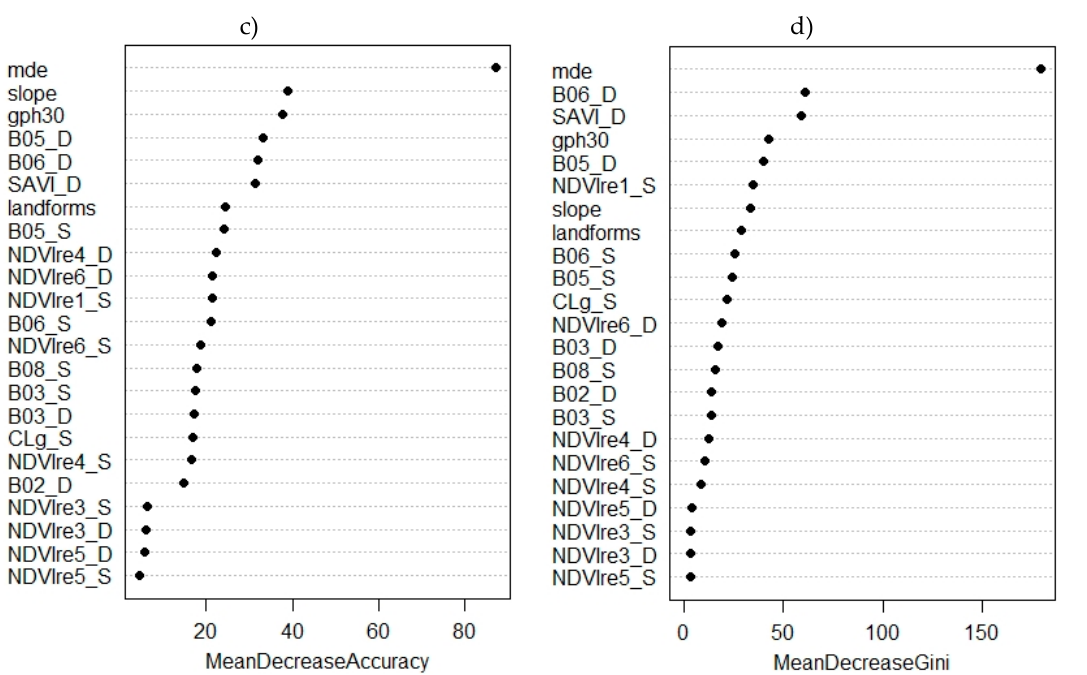
Figure 5. ( a ) Rank of covariates importance regarding accuracy decreasing (%); ( b ) rank of covariates importance regarding decreasing in Gini coe ffi cient (first taxonomic level); ( c ) rank of covariates importance regarding accuracy decreasing (%); ( d ) rank of covariates importance regarding decreasing in Gini coe ffi cient (fifth taxonomic level). Mde = Elevation, gph30 = Geomorphons. Bands and indices assigned with a ‘S’ correspond to September images (dry season), while those assigned with a ‘D’ correspond to December images (wet season) B02, B03, B05, B06, and B08 = Selected Sentinel-2 MSI bands; NDVIre = Normalized di ff erence vegetation index red-edge; CLg = Green chlorophyll index; SAVI = Soil-adjusted vegetation